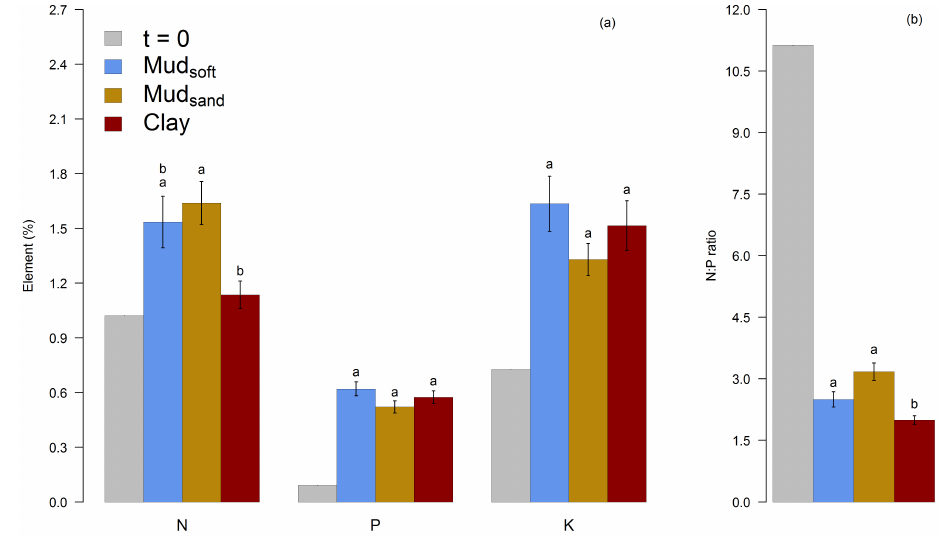
Figure 4. N, P and K concentration in root tissue ( t = 176) in percentage of dry weight (a) as well as the N:P ratio (b) with error bars when n = 5. Significant differences between sediment types are indicated by different letters, and nonsignificant differences are indicated by the same